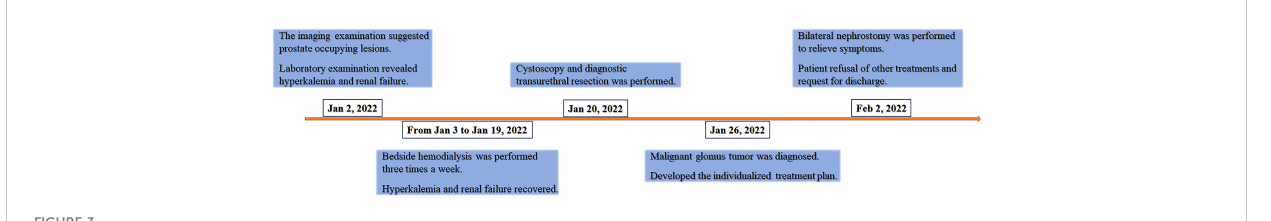
FIGURE 3 Treatment timeline of the malignant glomus tumor case.